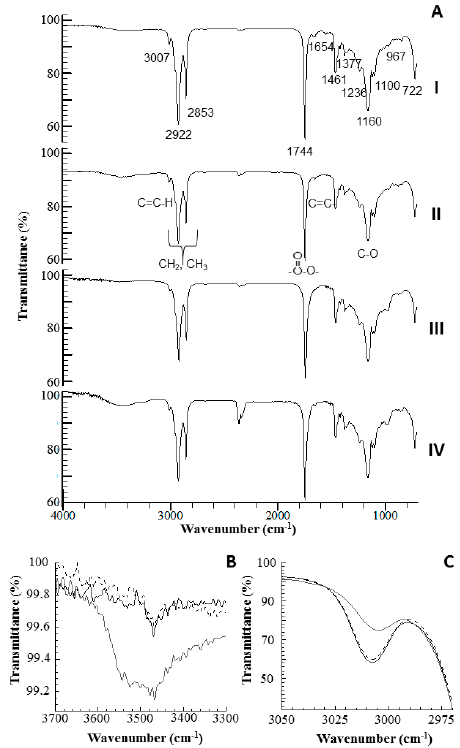
Figure 6. Thermal analysis of BO samples. ( A ) Thermogravimetric analysis—TGA ( — ) and differential